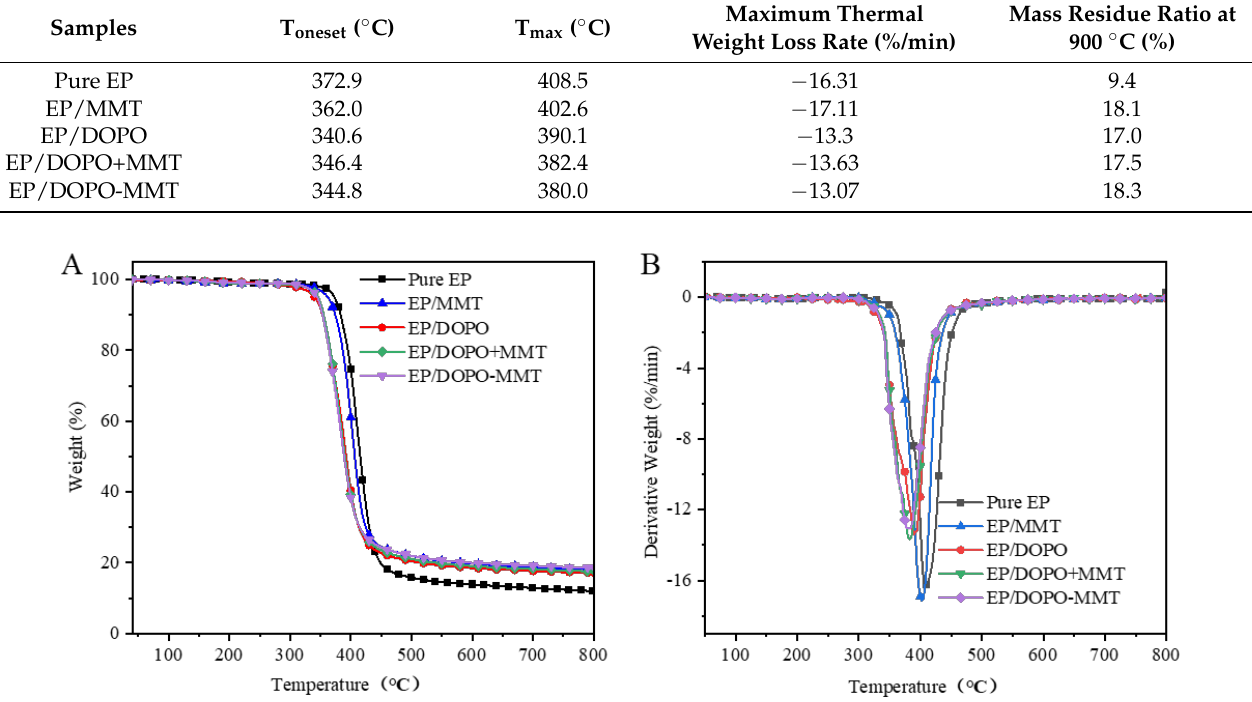
Figure 5. TG ( A ) and DTG ( B ) curves of EPs in N 2 Figure 5. TG(A) and DTG(B) curves of EPs in N 2.